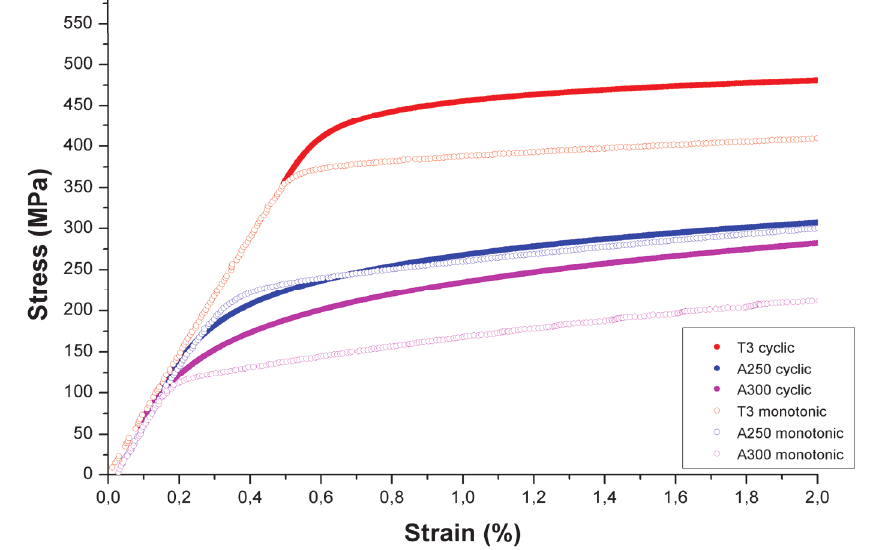
Figure 5: Monotonic & cyclic stress- strain curves of T3, A250 and A300